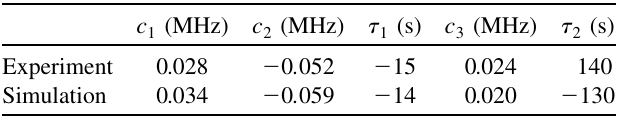
TABLE III. Fitting results for the transient experiment and simulation.